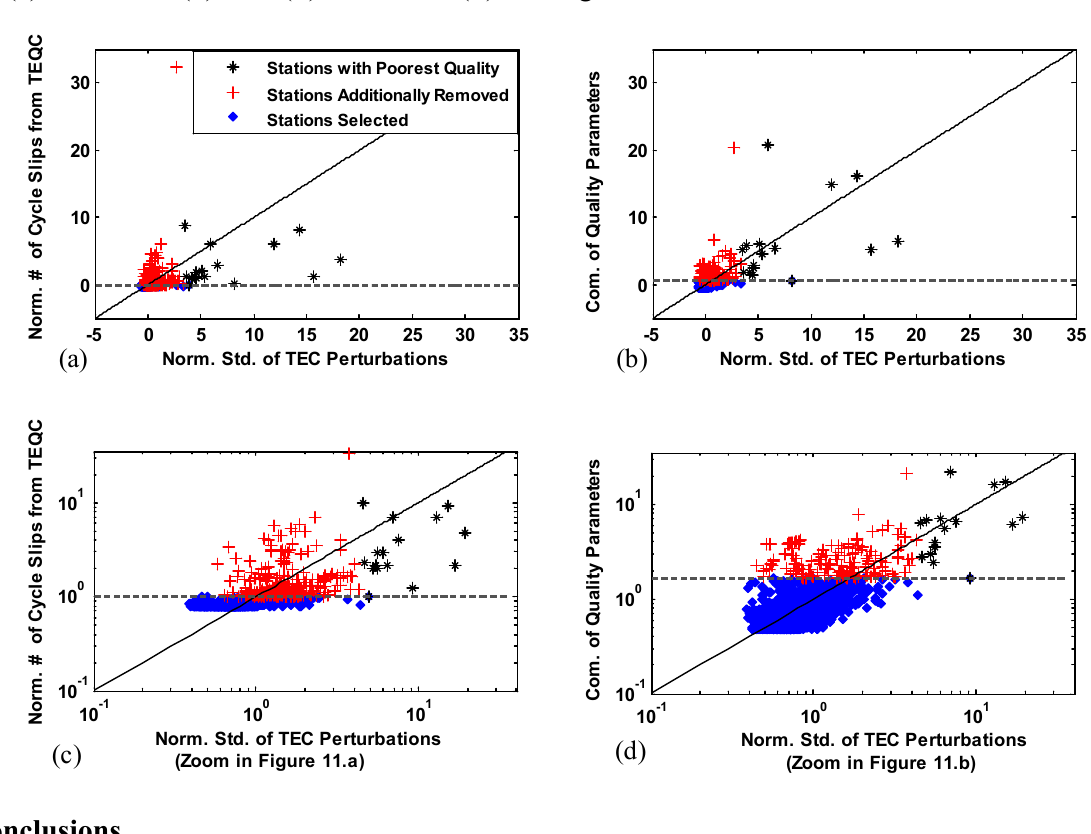
Figure 11. Station selection using: ( a ) the number of IOD cycle slips generated using TEQC; ( b ) combination of three quality parameters determined using the proposed method; ( c ) zoomed in ( a ); and ( d ) zoomed in ( b ) in a logarithmic